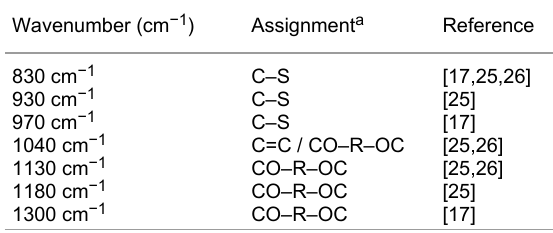
Table 1: Proposed assignments for the main vibrations of polythio- phene films.